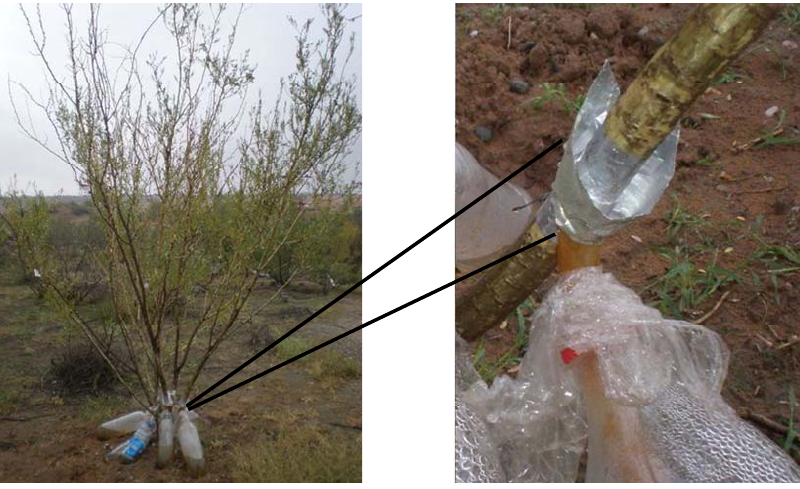
Fig. 1. Photographs showing method of collecting stemflow for C. korshinskii .